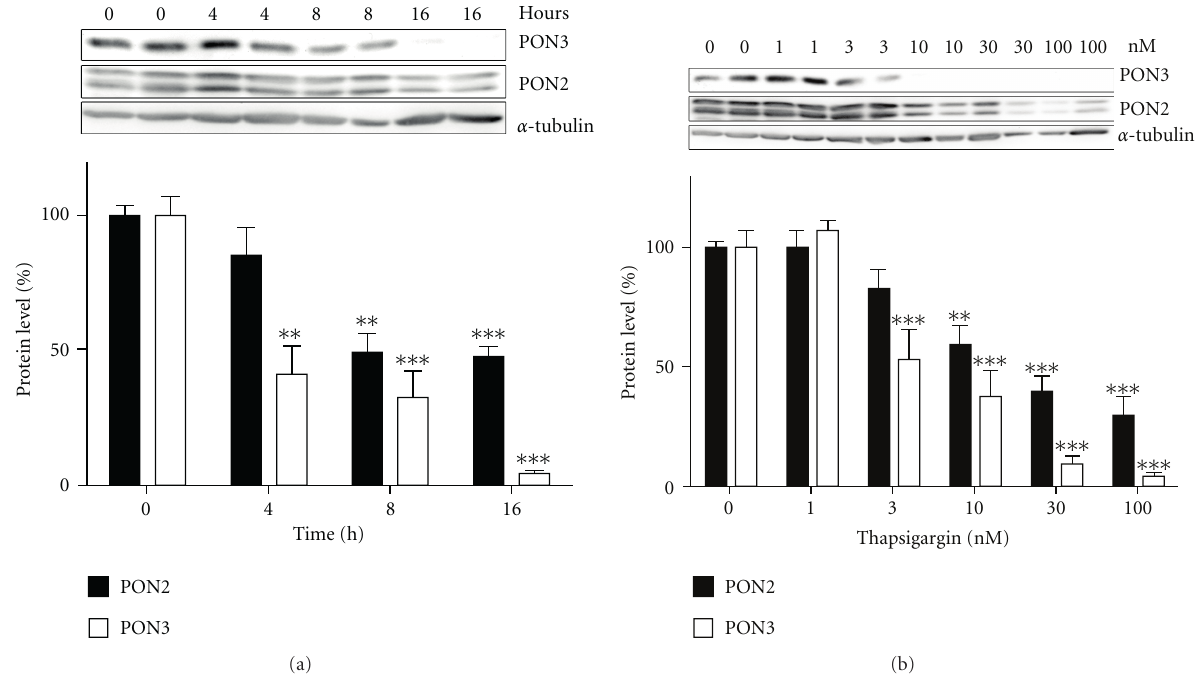
Figure 6: Both PON2 and PON3 are degraded after 3OC12 treatment. (a) A549 cells were treated with 3OC12 (100 μ M) for the indicated durations or (b) with thapsigargin (24h) with the indicated concentrations. Lysates (50 μ g of protein) were analyzed by Western blotting using anti-PON2, anti-PON3, or anti- α -tubulin antibodies. One representative blot is shown. Results (right) are the means ± S.E.M. of three replicate analyses; ∗∗ P < 0 . 01; ∗∗∗ P < 0 .